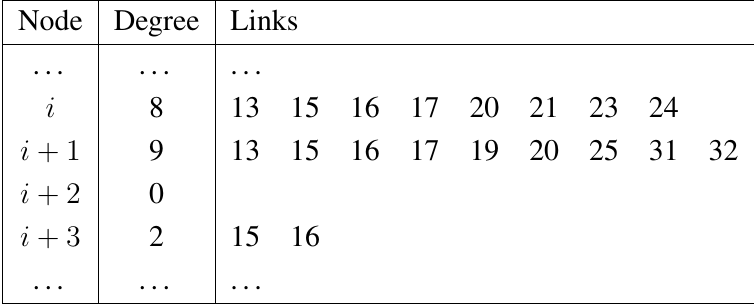
Table 2. An adjacency list. It is assumed that the node v